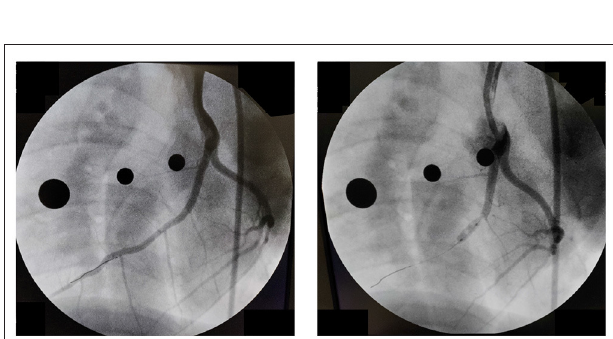
FIGURE 3 | Angiography pre- (Left) and post- (Right) occlusion of the Left Anterior Descending Coronary